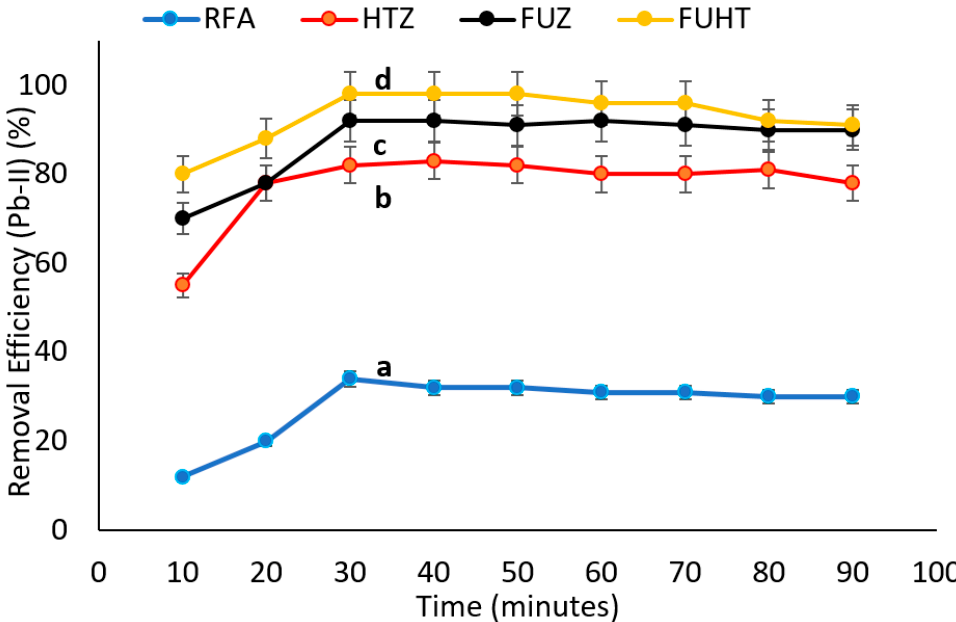
Figure 8. Effects of time variation on removal efficiency of Pb (II) at pH ≈ 8 and 1 g/100 mL of mass of adsorbent (RFA and Na-zeolites) at 25 °C. Notes: a,b,c,d shows significant ( p < 0.05) differences among different zeolite samples.